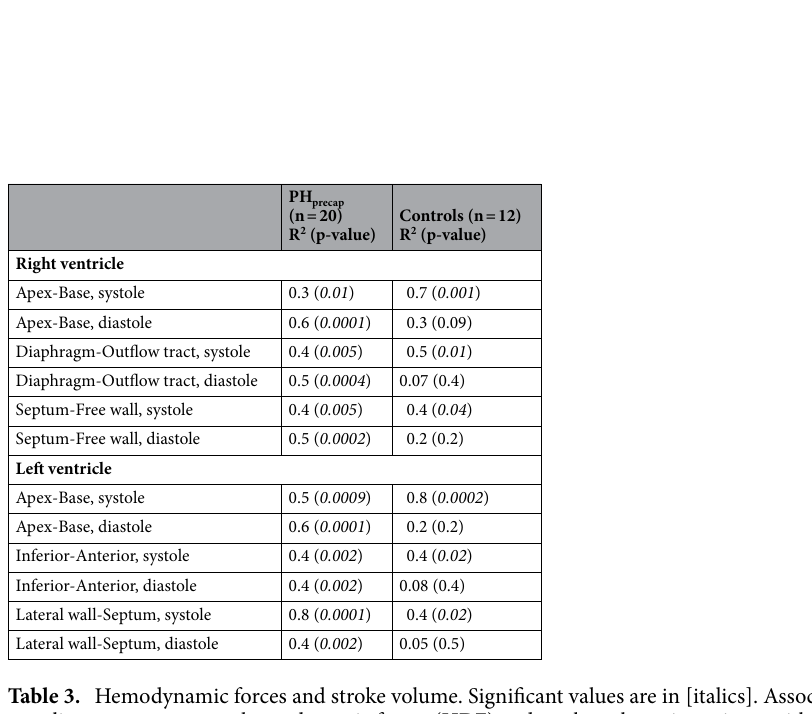
Figure 5. Root mean square (RMS) left ventricular hemodynamic forces in patients with precapillary pulmonary hypertension (PH precap , circles) compared to healthy controls (squares). RMS hemodynamic forces indexed to left ventricular stroke volume (SV) during systole (top row) and diastole (bottom row), in the apex- base direction (left column, red), inferior-anterior direction (middle column, green), and lateral wall-septum direction (right column, blue).